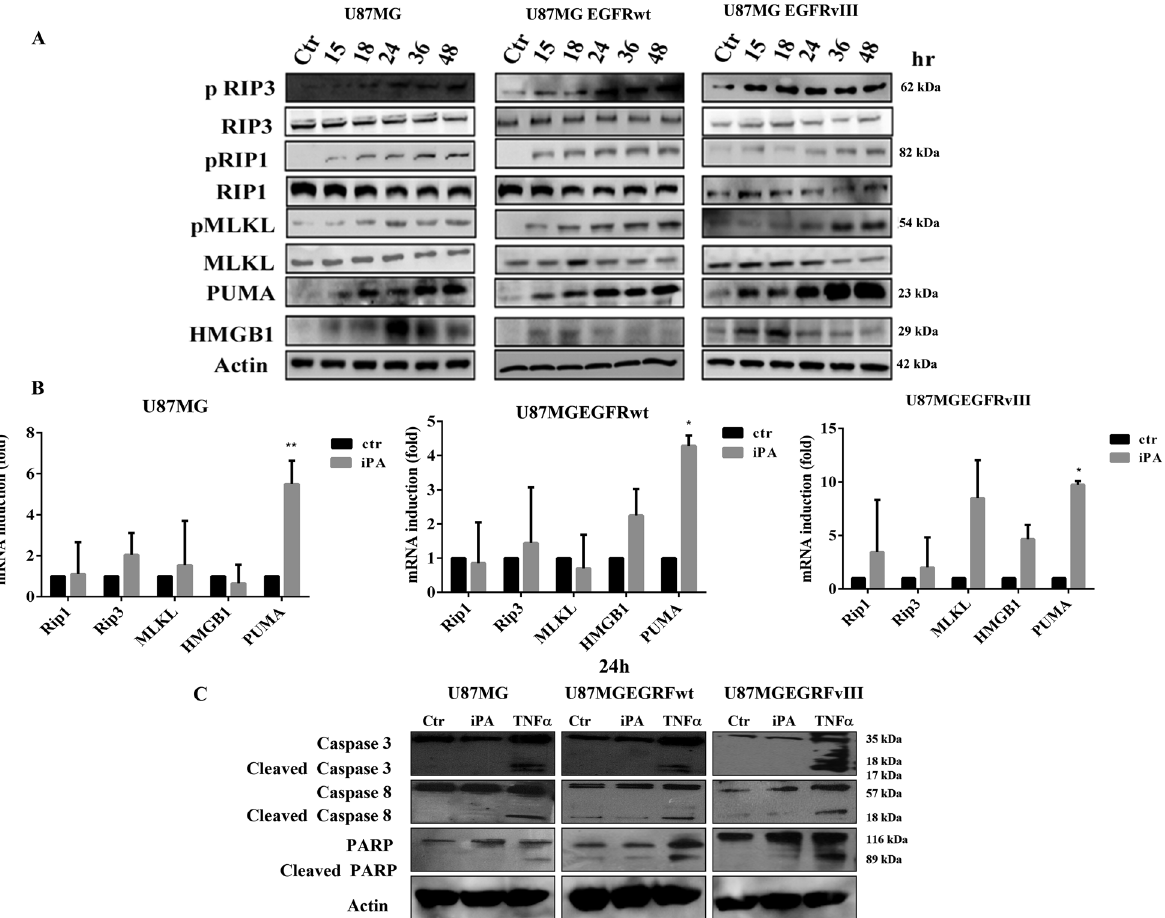
Fig. 4 iPA induces phosphorylation of necroptosis ’ s markers. A Representative Immunoblotting images of Necroptosis protein levels. After treatment with iPA 10 µM at different timepoints (15 – 48 h), the activation levels of pRIP1, pRIP3, and p-MLKL and the protein levels of PUMA, HMGB1 were increased. B Relative expression levels of Necroptosis markers after iPA treatment. Each bar represents the SD value from three independent replicates. C Representative Immunoblotting images of Caspase-3, Caspase-8, and PARP1 protein levels after treatment with iPA 10 µM at 24 h. The data are presented as mean ± SD of at least three independent experiments. * p < 0.05, ** p < 0.01, *** p < 0.001, **** p < 0.0001 versus control, represented by cells treated with vehicle (DMSO).